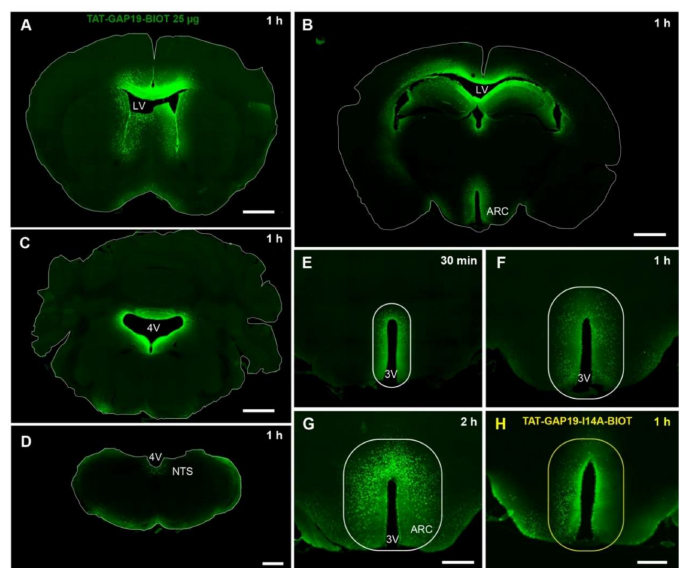
Figure 5. ( A – D ): Di ff usion of biotinylated TAT-GAP19 into the hypothalamus ( A , B ) and hindbrain ( C , D ) 1 h after its i.c.v. administration. White lines delimit brain tissue. Scale bars: 1 mm in ( A ) and ( C ); 500 µ m in ( C ) and ( D ). ( D – F ) : High magnification of biotinylated TAT-GAP19 25 µ g di ff usion within the hypothalamus 30 min ( D ), 1 h ( E ) and 2 h ( F ) after its injection into the lateral ventricles. Scale bar: 500 µ m. ( G ): High magnification of biotinylated TAT-GAP19-I14A 25 µ g di ff usion within the hypothalamus 1 h after its injection into the lateral ventricles. Scale bar: 500 µ m. ( H ): High magnification of biotinylated TAT-GAP19-I14A di ff usion within the hypothalamus 1 h after its injection into the lateral ventricles. White lines ( D – G ) and yellow lines ( H ) delimit di ff usion area of biotinylated peptides. ARC: arcuate nucleus; 3V: third ventricle; 4V: fourth ventricle; NTS: nucleus tractus solitarius; LV: lateral